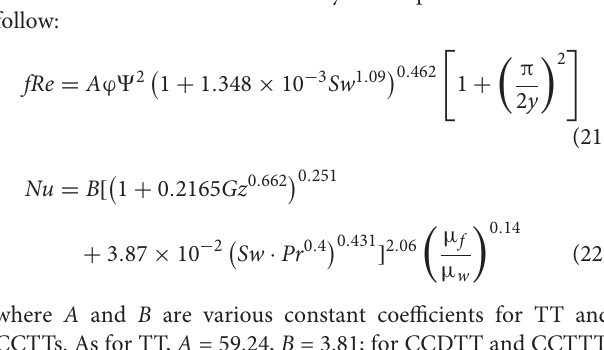
CCDTT or CCTTT are uniformly developed and defined as